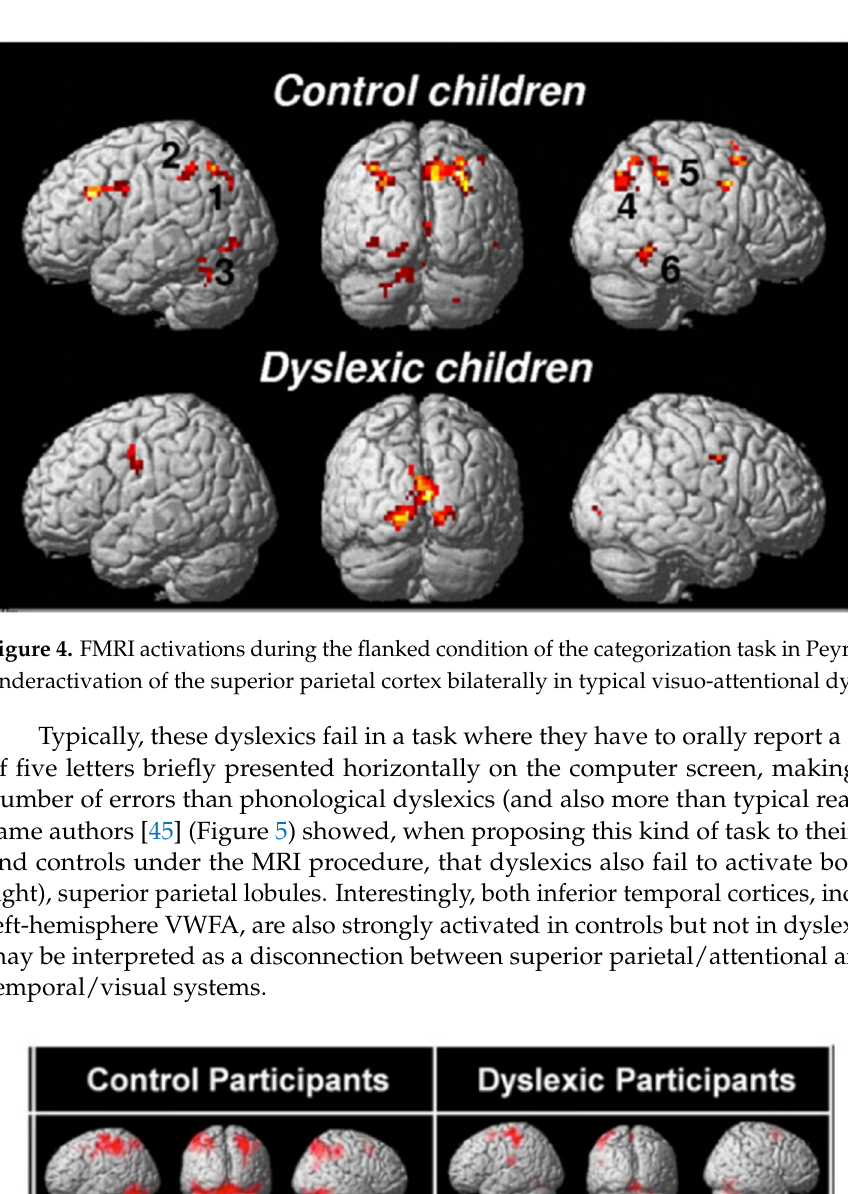
Figure 3. Example of stimuli used by Peyrin et al. [44] in their categorization task. Participants had to decide whether the stimuli of a pair were identical or not. Parafoveal stimuli were lateralized in either the right or left visual field, masked by two X in the flanked condition ( left side of the fig- ure) and displayed alone in the isolated condition ( right side ).